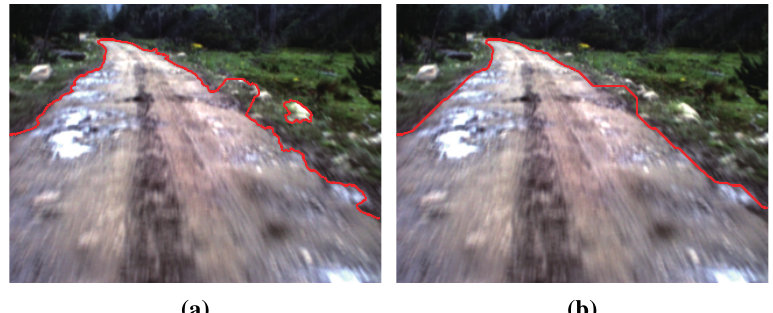
Figure 17. Comparison between the results of GrowCut and refinement: ( a ) the result of GrowCut; ( b ) the result of refinement.